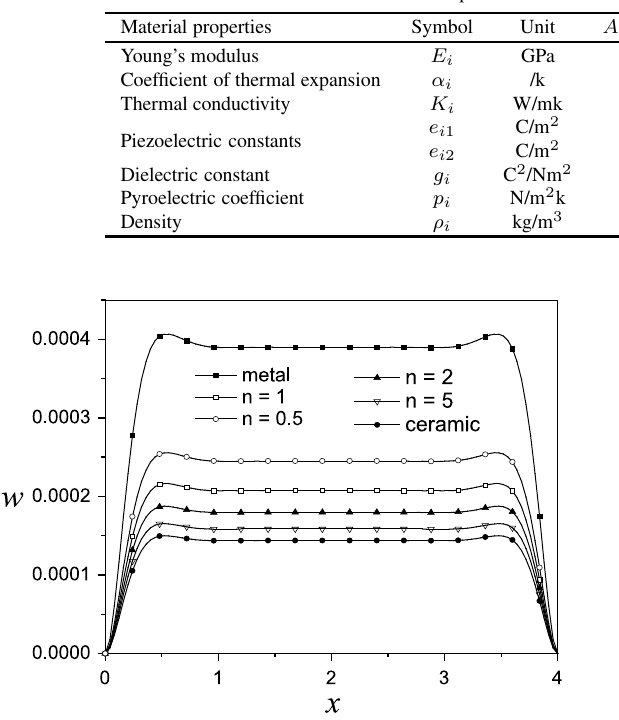
Fig. 4. Deflection of the mid-plane for the clamped supported FGPM cylindrical shell imposed by a uniform mechanical load, with different volume fraction index n ( q = 1 MPa, T 1 = 0 , T 2 = 0 , a = 1 m, L = 4 m, a/h = 20 , φ 1 = 0 , φ 2 = 0 ).